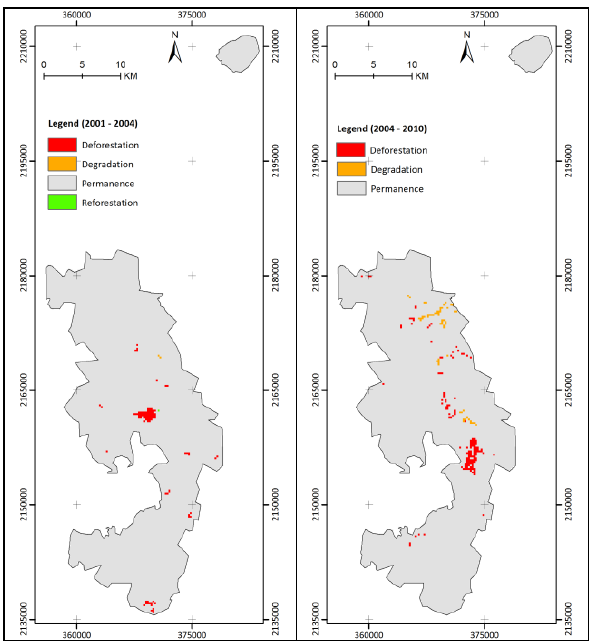
Figure 4. Forest change patches by visual interpretation of SPOT-5 images of Monarch Reserve for the period of 2001- 2004 (left) and 2004-2010 (right).